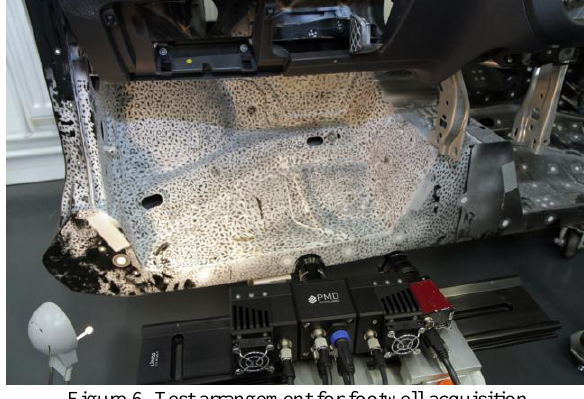
Figure 6. Test arrangement for footwell acquisition